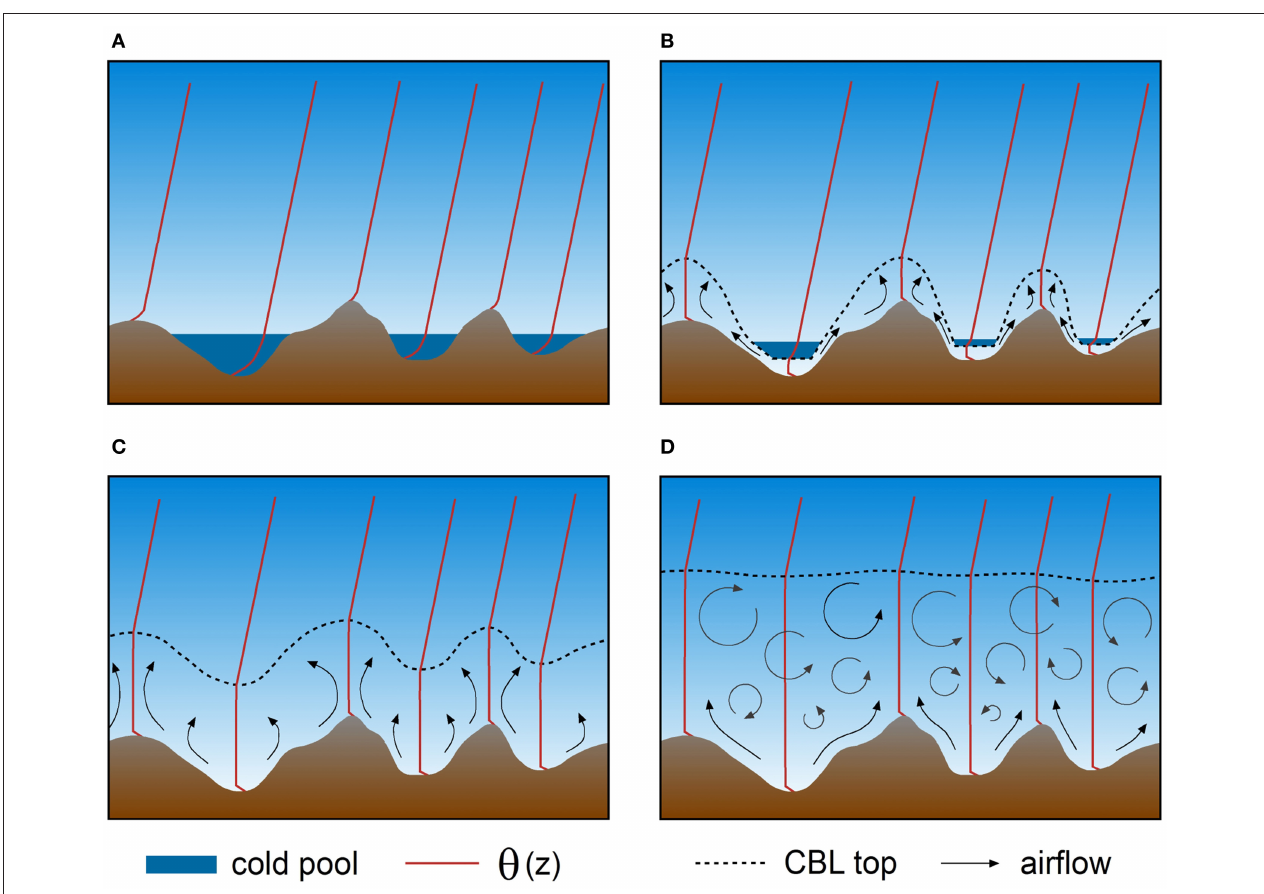
FIGURE 8 | Conceptual model of the CBL development over mountainous terrain on a fair weather day (A) before sunrise, (B) in the early morning, (C) at noon, and (D) in the late afternoon. Dark blue shading indicates strongly stable stratification in nocturnal cold air pools. Arrows indicate thermal circulation and turbulent mixing. The dashed lines indicate the top of the turbulent CBL. Vertical profiles of potential temperature θ are shown in red at several locations along the cross section (after Fiedler et al.,